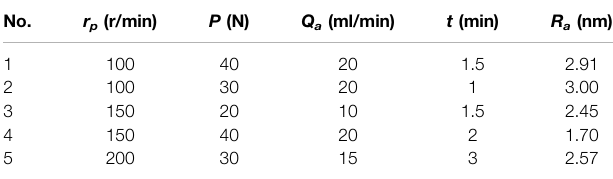
TABLE 2 | Experimental results in the polishing process. TABLE 3 | Additional experimental results in the polishing